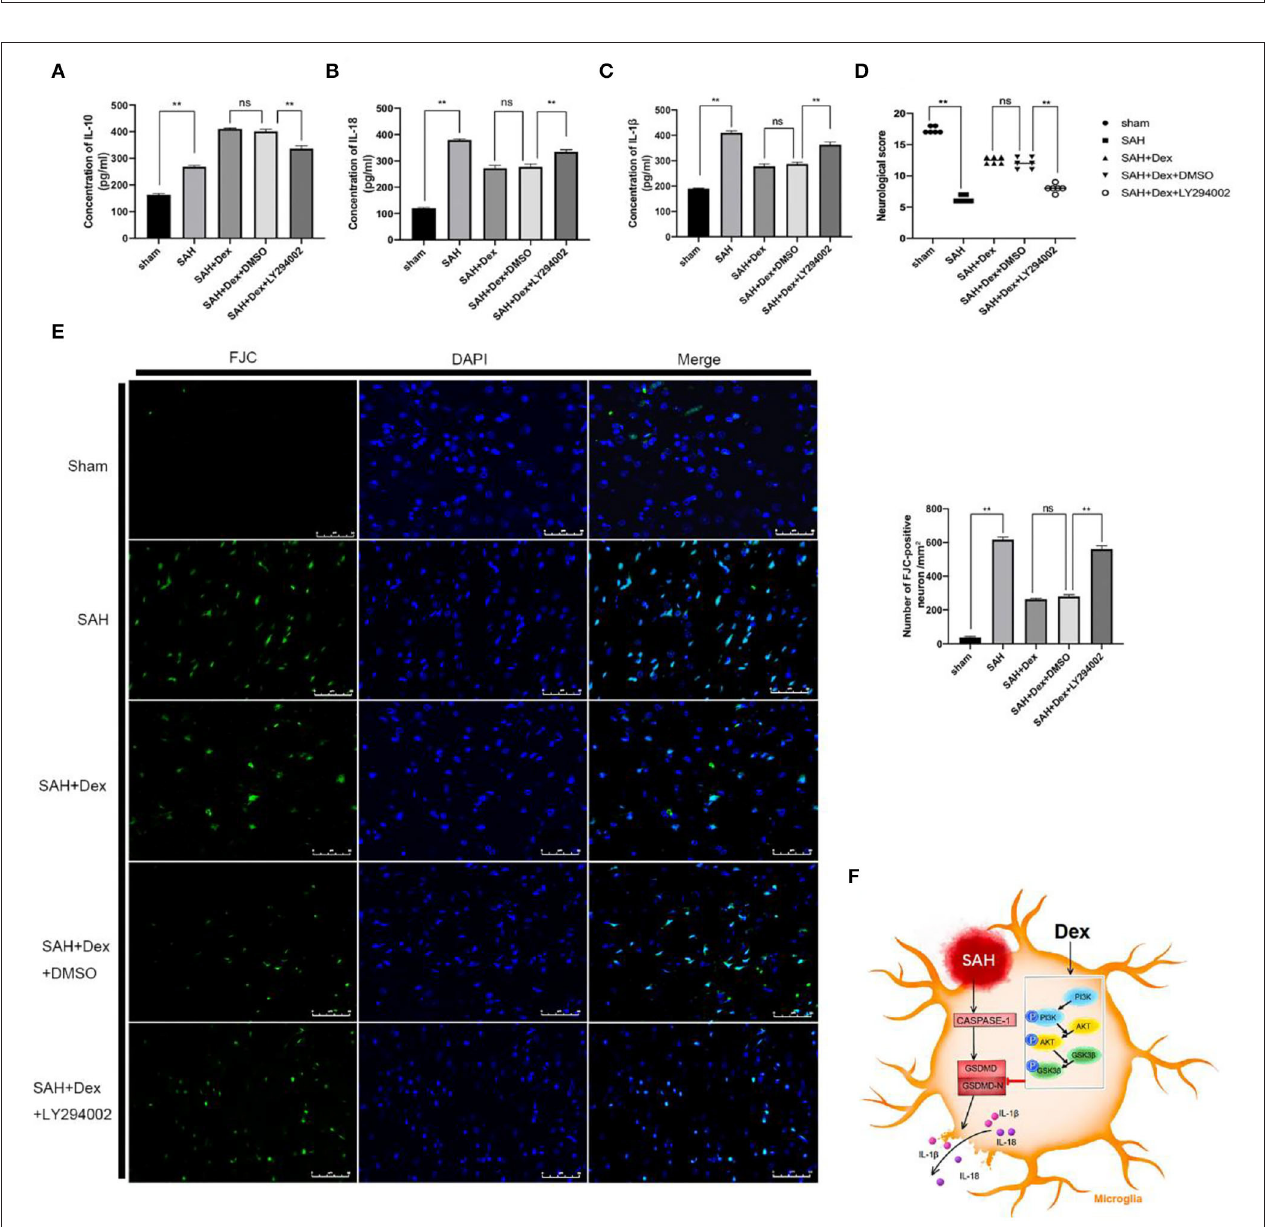
FIGURE 8 | immunofluorescence staining of GSDMD in ipsilateral cerebral cortex. Scale bar = 50 µ m. (D,G,H) Representative images of immunofluorescence staining and quantification of CD68 and IBA1 activation in ipsilateral cerebral cortex at 24h post-SAH; Scale bar = 50 µ m. n = 6 in each group; data are expressed as